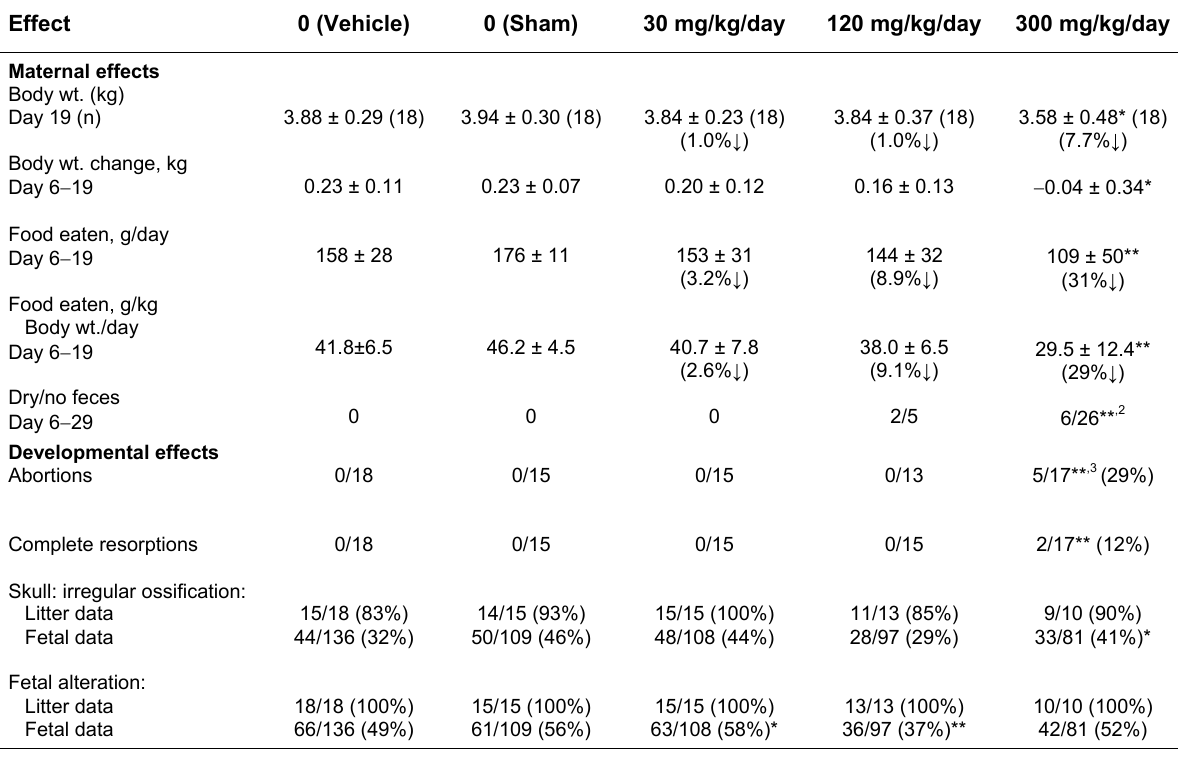
Developmental Toxicity of Resmethrin in the New Zealand White Rabbit